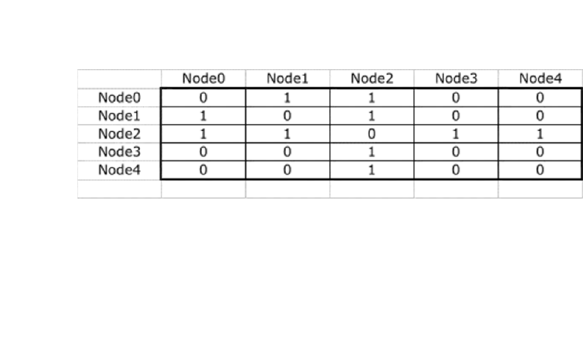
Figure 1. A simple network with 5 nodes (assets) and 5 links (connections) representing a road system, along with the connection matrix that defines the mapping of links to pairs of nodes. The node and link vulnerabilities are shown as probabilities that each will fail in a “domino effect” cascade.